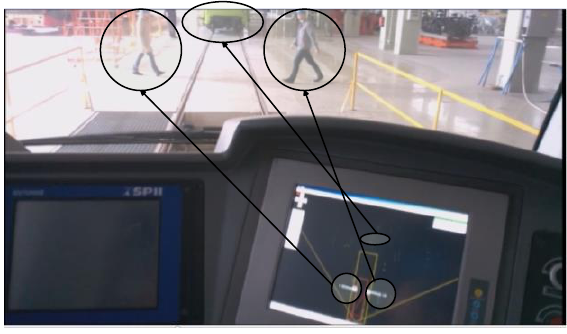
Figure 13. The scenarios for multiple pedestrian and static LRV.